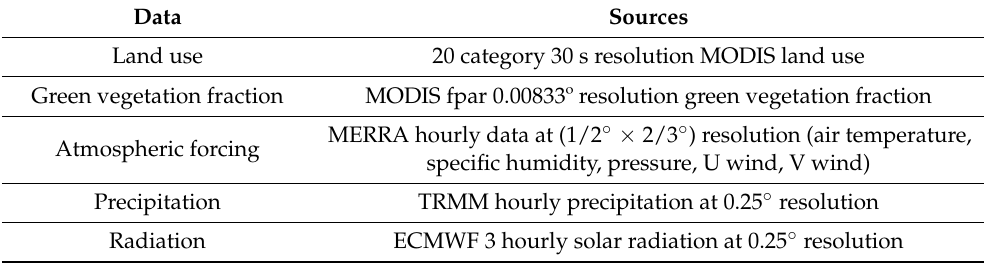
Table 1. Data used.